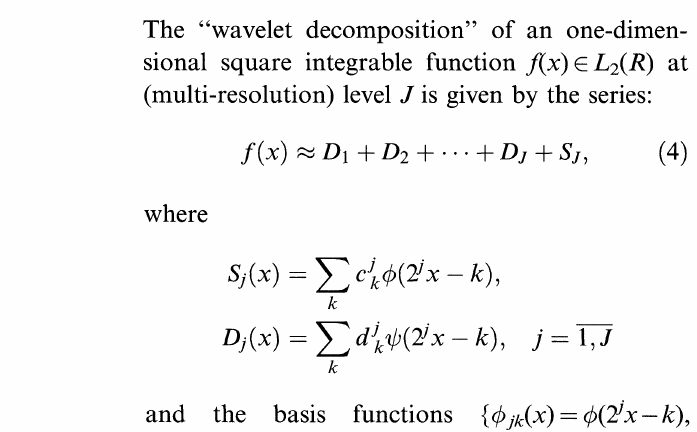
FIGURE 5 Distributions of Error and Relative error for the CNN neural